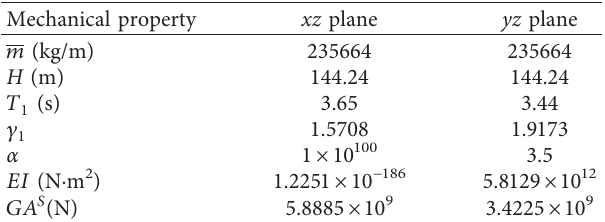
Figure 7: First lateral modes of vibration of a fixed-base 3D FEM [55]. (a) Lateral resisting system. (b) T Table 6: Mechanical properties of the fixed-base CSF discrete